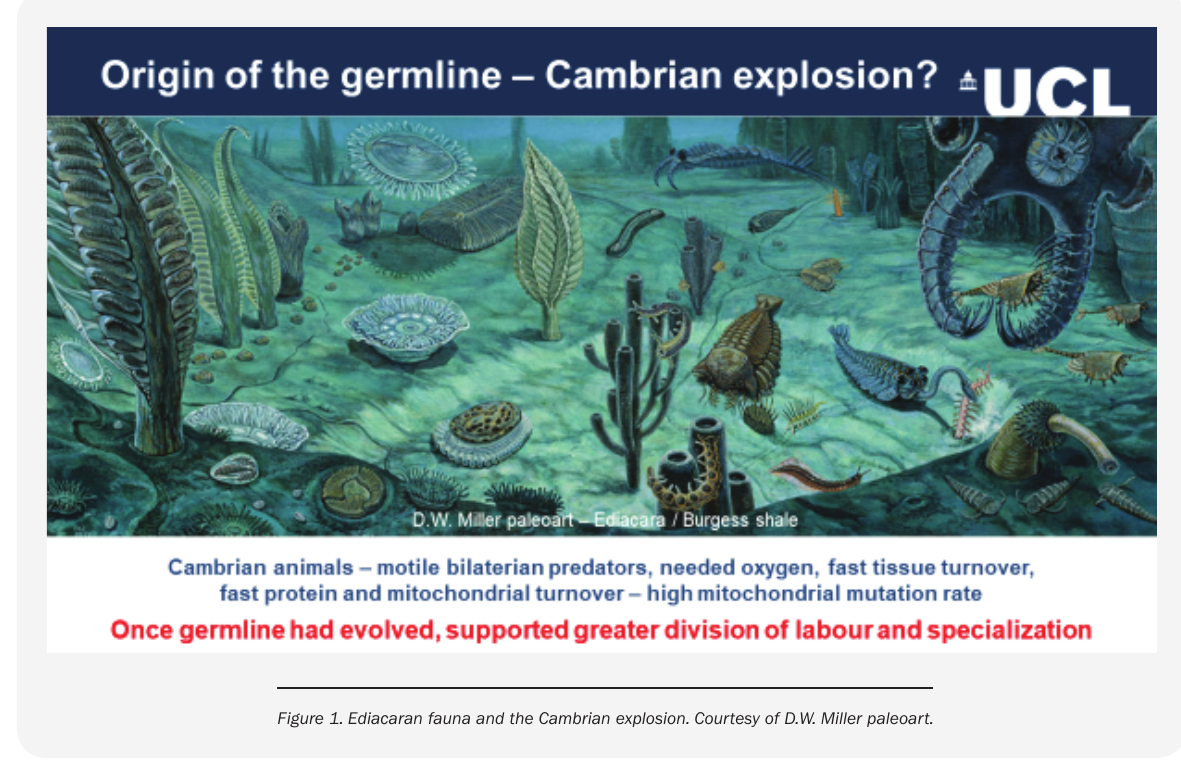
Figure 1. Ediacaran fauna and the Cambrian explosion. Courtesy of D.W. Miller